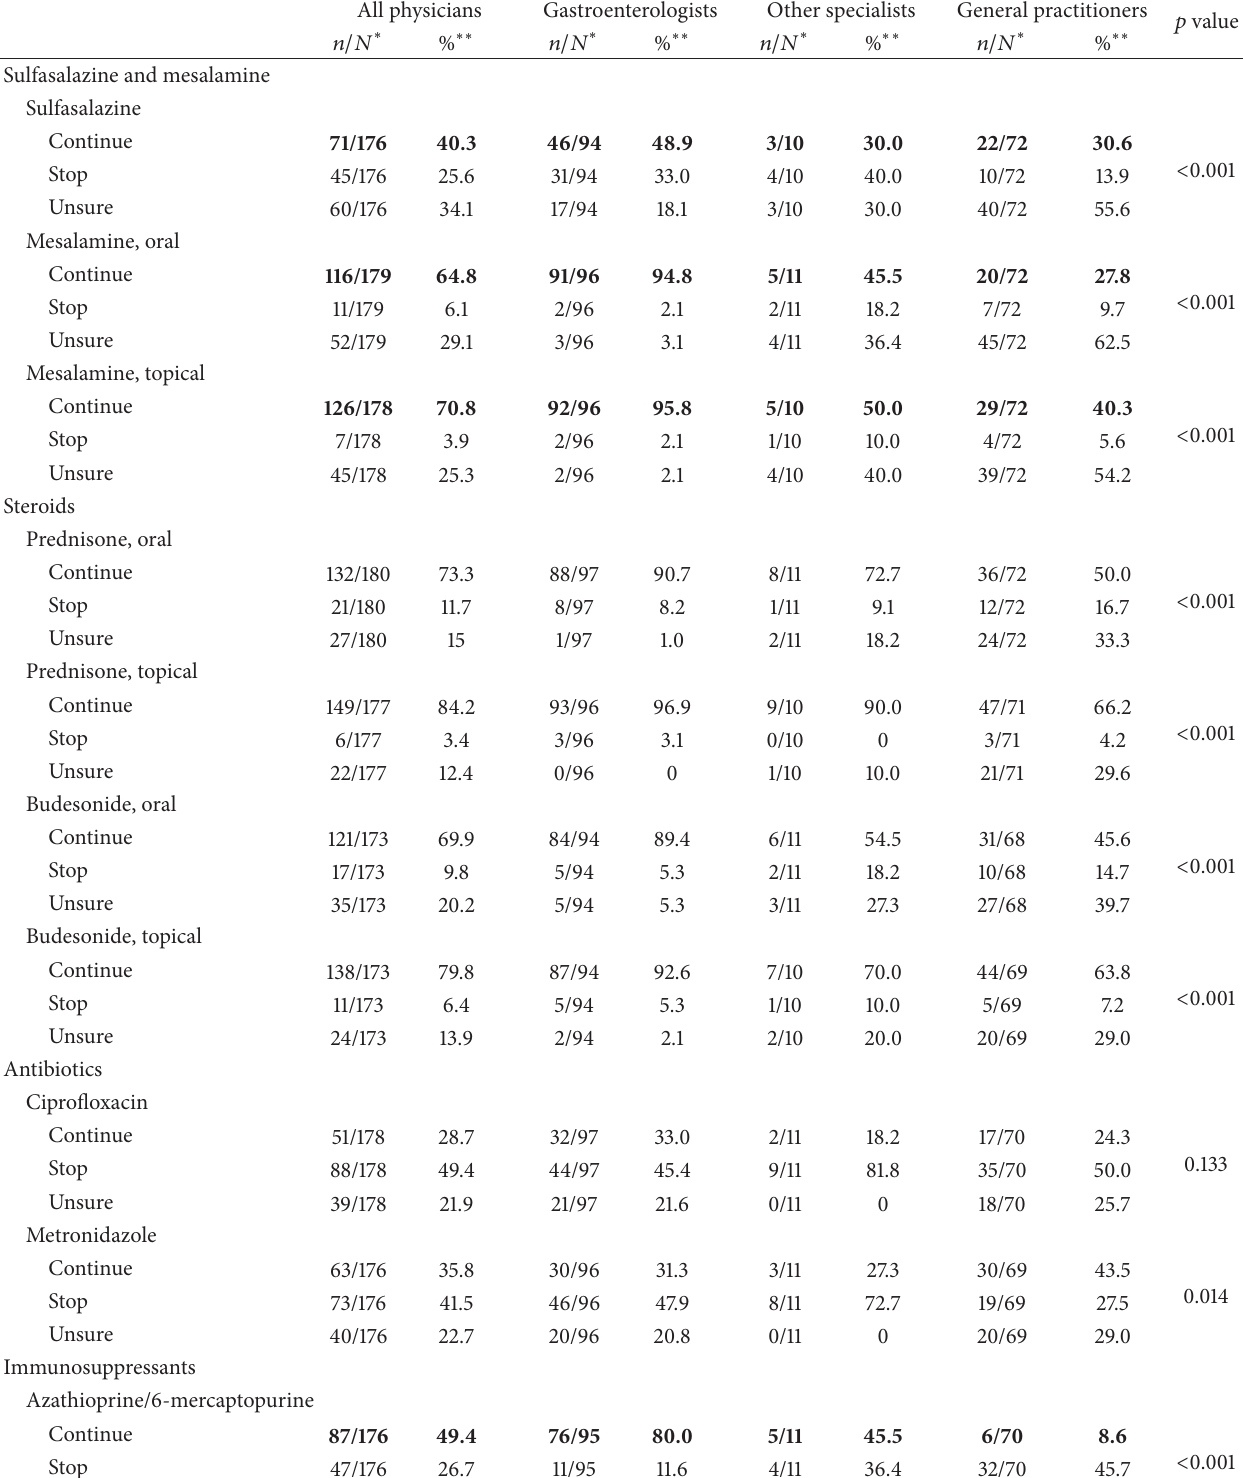
Table 4: Continuation of commonly used IBD medications for women with IBD during breastfeeding by physician training status: a survey of practicing Canadian